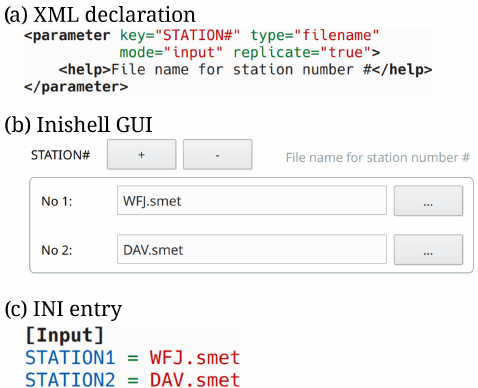
Figure 8. Simple example of templates to generate as many in- put widgets as the user deems necessary with an auto-numbering scheme (panels a , b , and c are similar to those of Fig. 6).